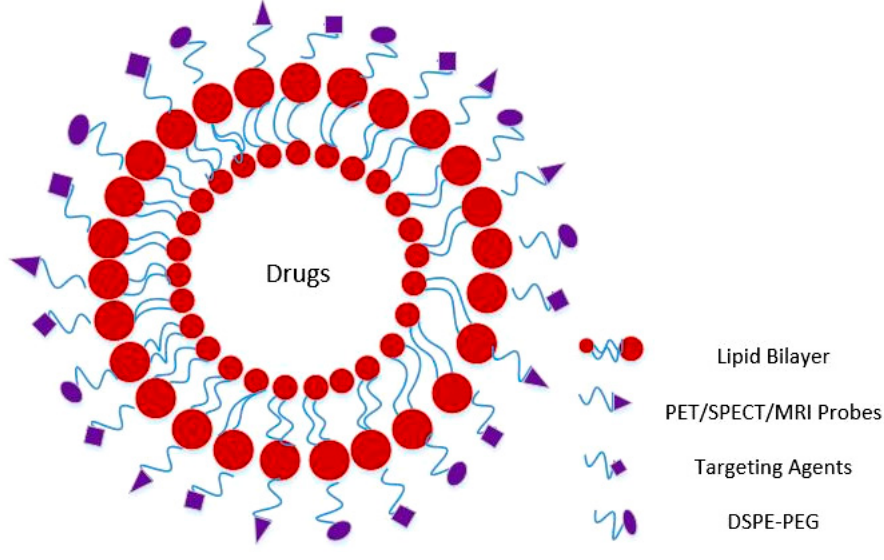
Figure 1. Schematics of a functionalized liposome.